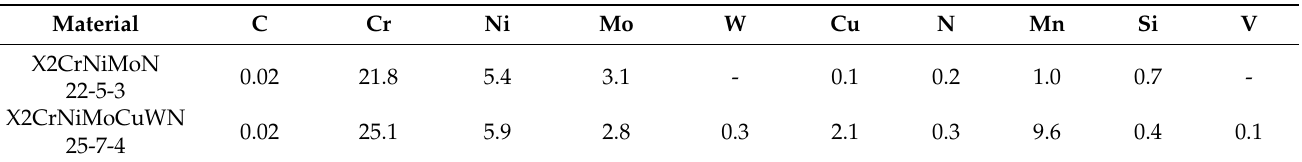
Table 1. Chemical composition of the starting materials in mass%, measured by means of optical emission